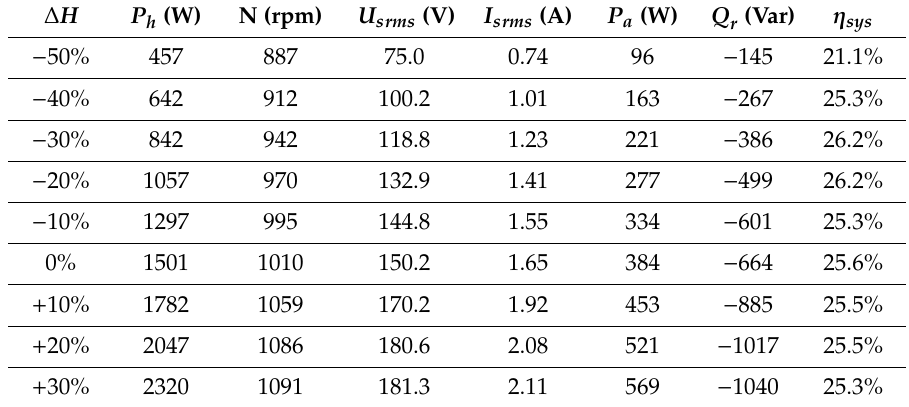
Table 9. Steady-state hydraulic and electromechanical quantities after a sudden change in the PAT